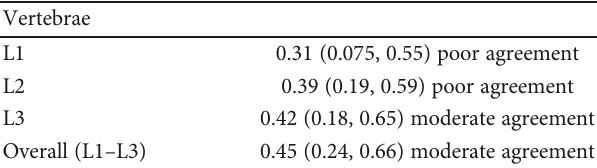
Table 2: DXA versus QCT Cohen kappa statistics, per level and